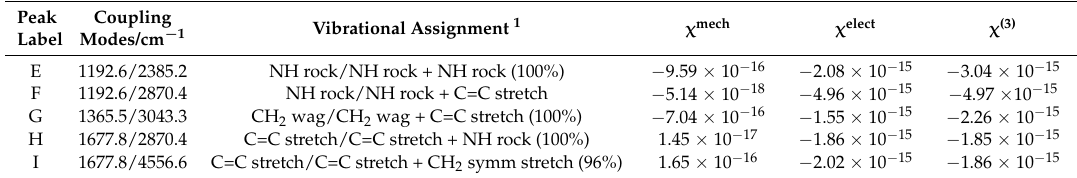
Table 2. The vibrational mode pairs corresponding to the characteristic cross peaks in the enamine tautomer LM1B and their respective